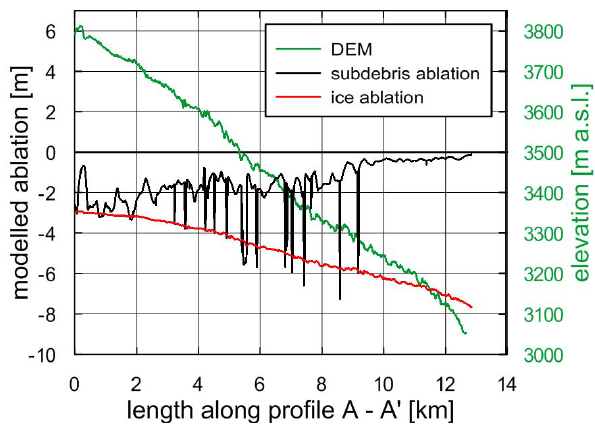
Fig. 10. DEM (green line), ice ablation (red line) and subdebris ab- lation (black line) along the profile A–A 0 (Fig. 1) for the exponential regression of debris cover